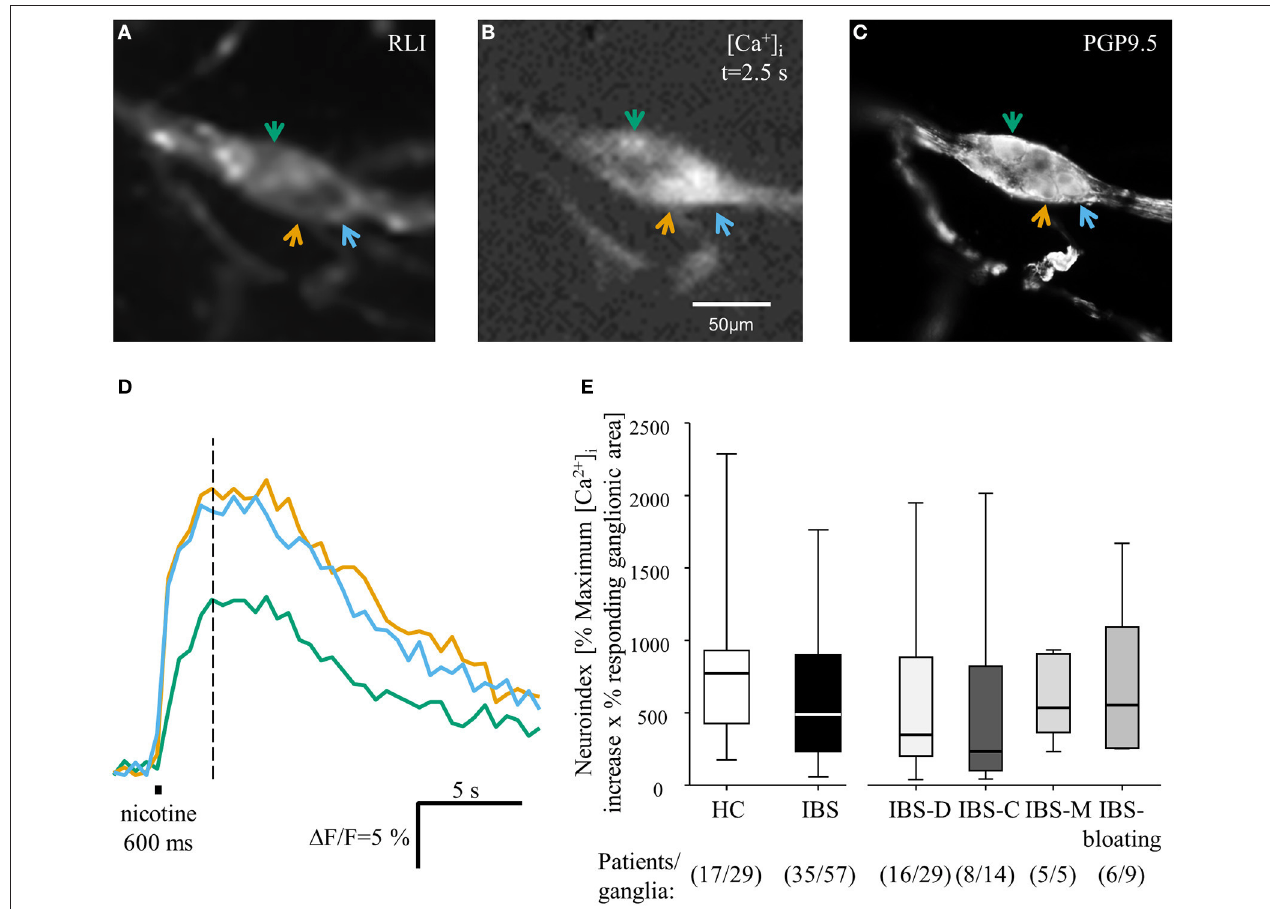
FIGURE 1 | Neuronal responses to the spritz application of 100 µ mol/l nicotine in human submucous ganglia obtained from IBS and HC biopsies. (A) Image of a Fluo-4 AM labeled ganglion before nicotine application taken with the low resolution CCD camera. (B) Image 2.5s after nicotine application showing a peak response in three large diameter cells marked by arrows. (C) The same ganglion after PGP 9.5 staining revealed that the three responding cells were neurons (image taken with a high resolution camera of the fluorescent microscope). (D) Trace of the three neurons reflect the intracellular calcium increase in response to the application of nicotine (colored traces respond to colored arrows in A–C ). (E) Nicotine evoked responses did not differ between HC and IBS ganglia. The increase in the neuroindex was comparable. There were also no differences among IBS